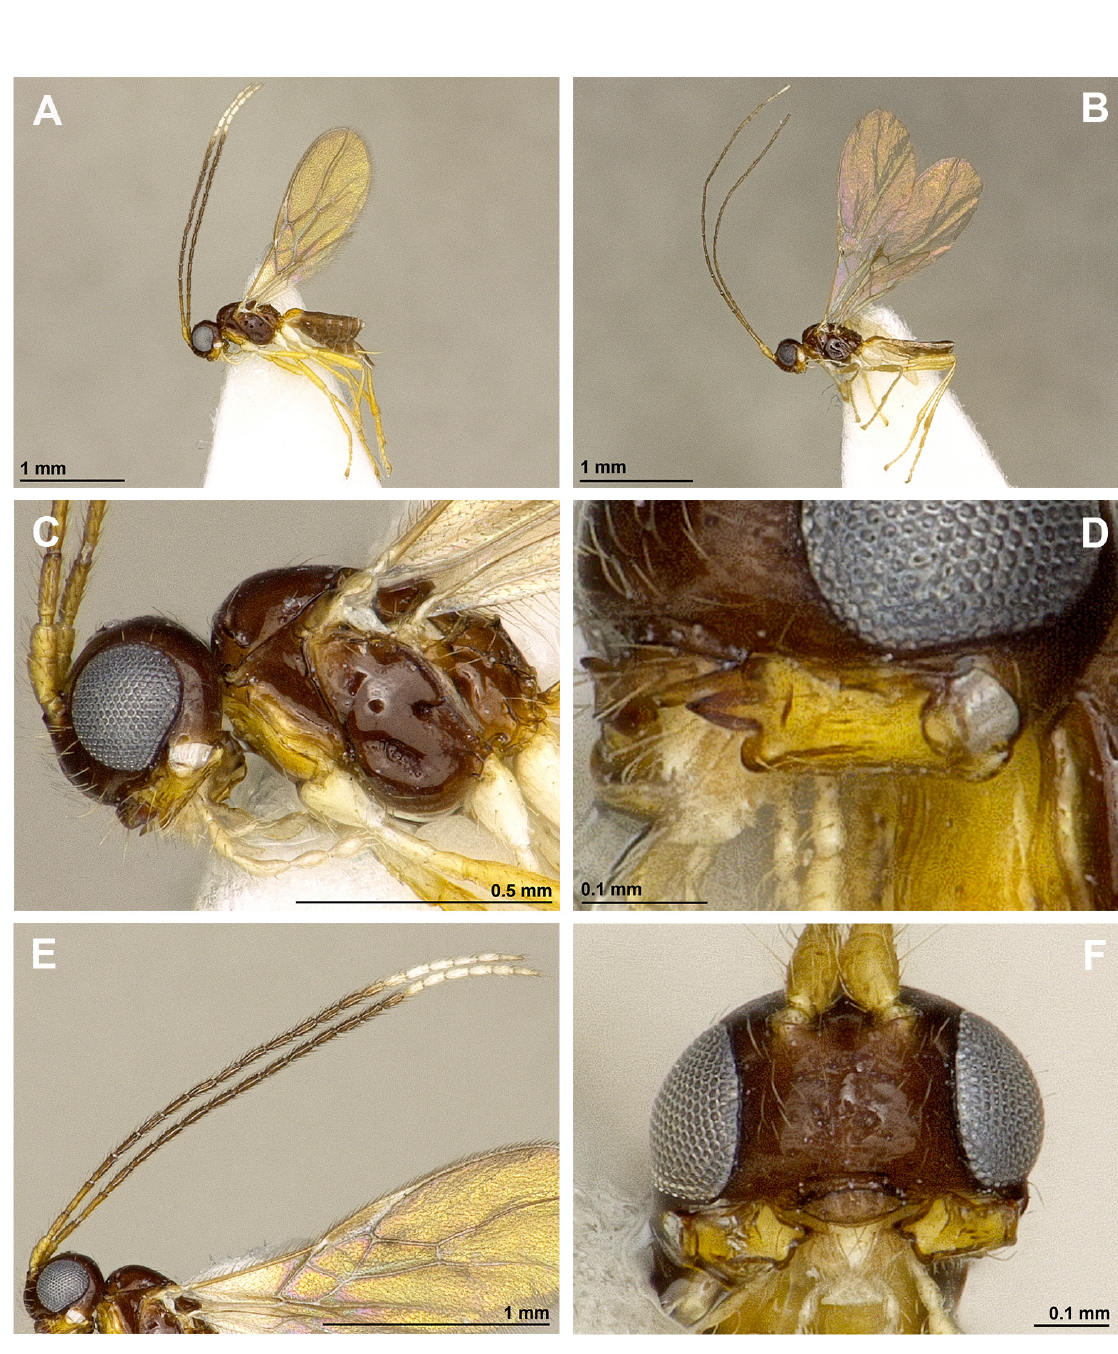
Fig. 39. Asobara mediana van Achterberg, sp. nov., A, C–F: ♀, holotype (RMNH); B: ♂ (RMNH). A–B . Habitus, lateral view. C . Head and mesosoma, lateral view. D . Mandible. E . Antenna. F . Head, front